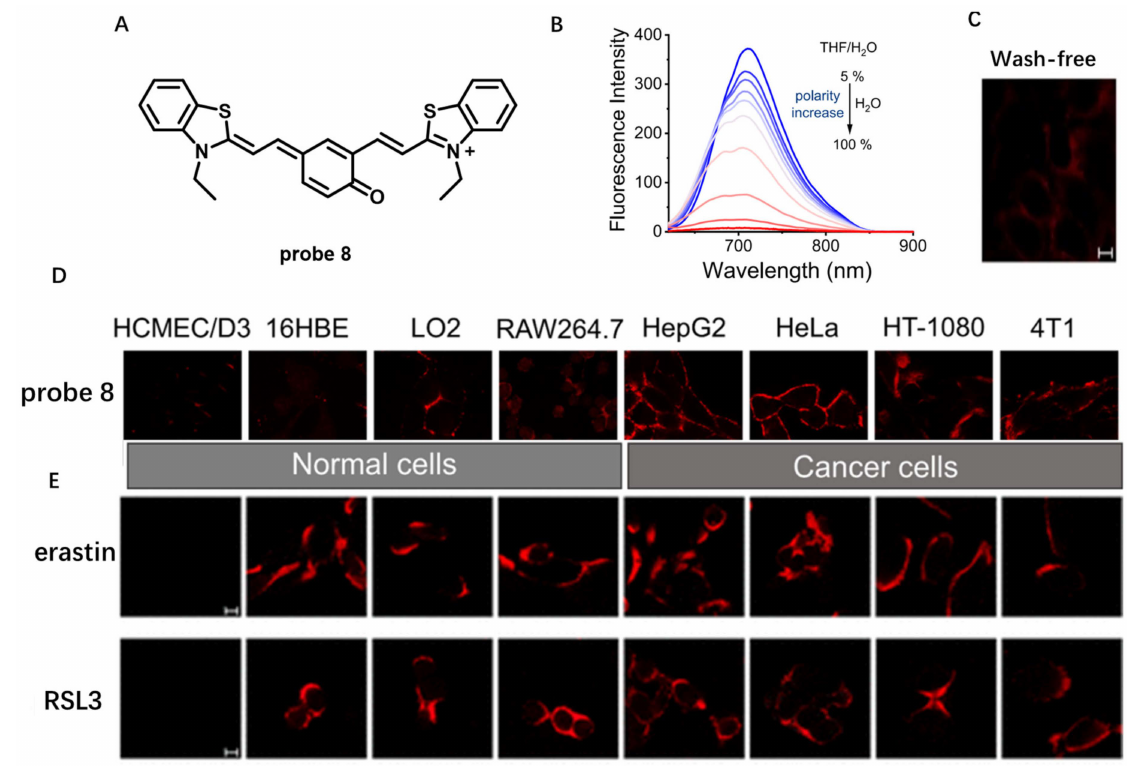
Figure 7. ( A ) Chemical structure of probe 8 . ( B ) Fluorescence spectra of probe 8 in THF/H2O mixtures with different volume proportions. ( C ) Wash-free imaging HeLa cells using 100 nM probe 8 . ( D ) Distinguishing fluorescence imaging of normal cells and cancer cells using probe 8 ( λ ex = 561 nm, λ em = 600 − 700 nm). ( E ) Fluorescence imaging of HT-1080 cells during ferroptosis. Scale bar: 10 µ m. Copyright 2022 American Chemical Society